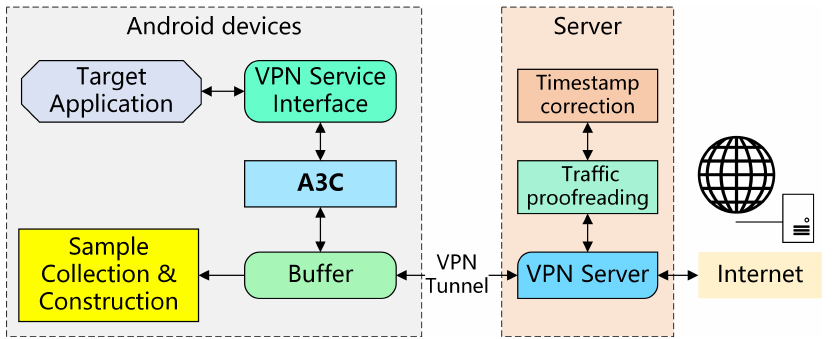
Figure 6. A3C-Android sample collection and